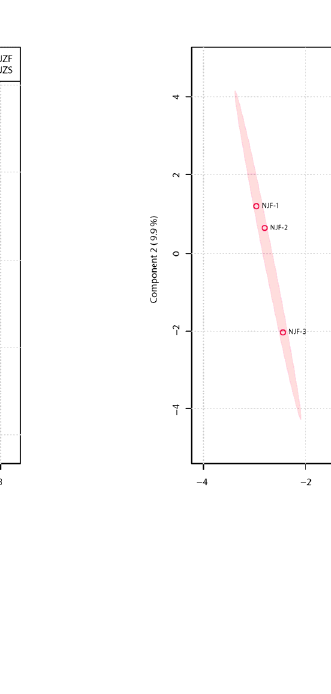
Figure 2. The protein variation between different varieties. ( a ) Venn plot; ( b ) PCA of protein profiles.